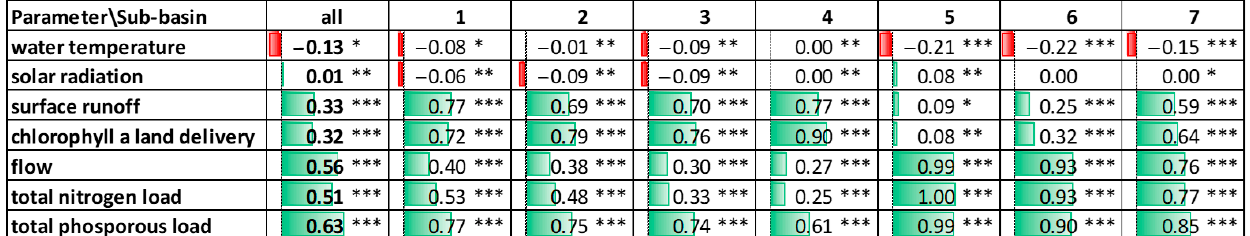
Table 1. The R values for the relations of chlorophyll a and selected parameters ( p -value below